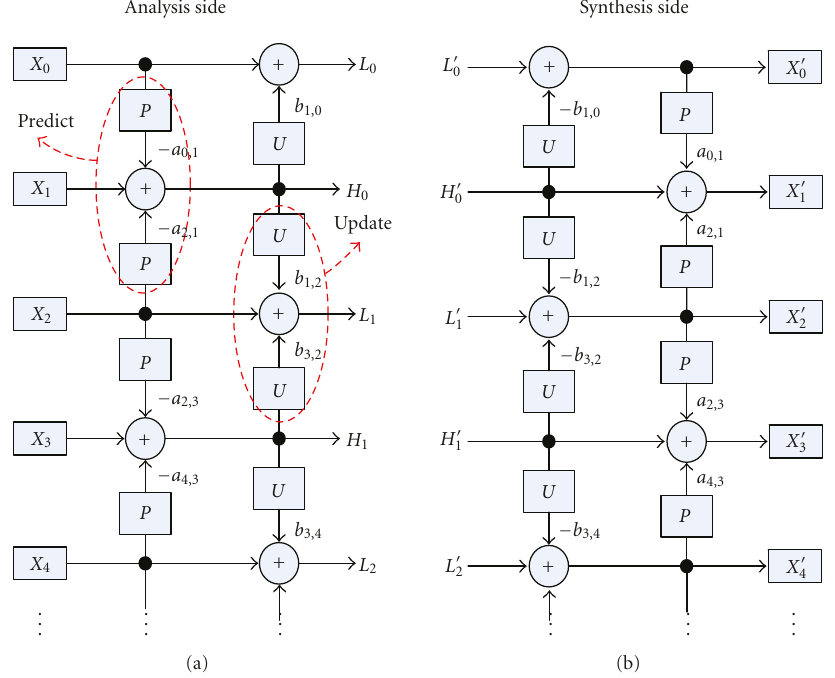
Figure 3: The first level decomposition of disparity compensated 5/3 wavelet